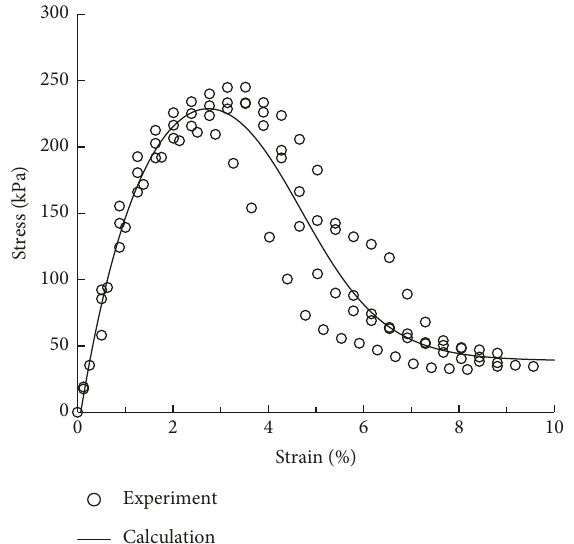
Figure 12: Fitting result of stress-strain curve of cement and fiber admixed slurry with a cement content of 20% and a fiber content of 0.25%.